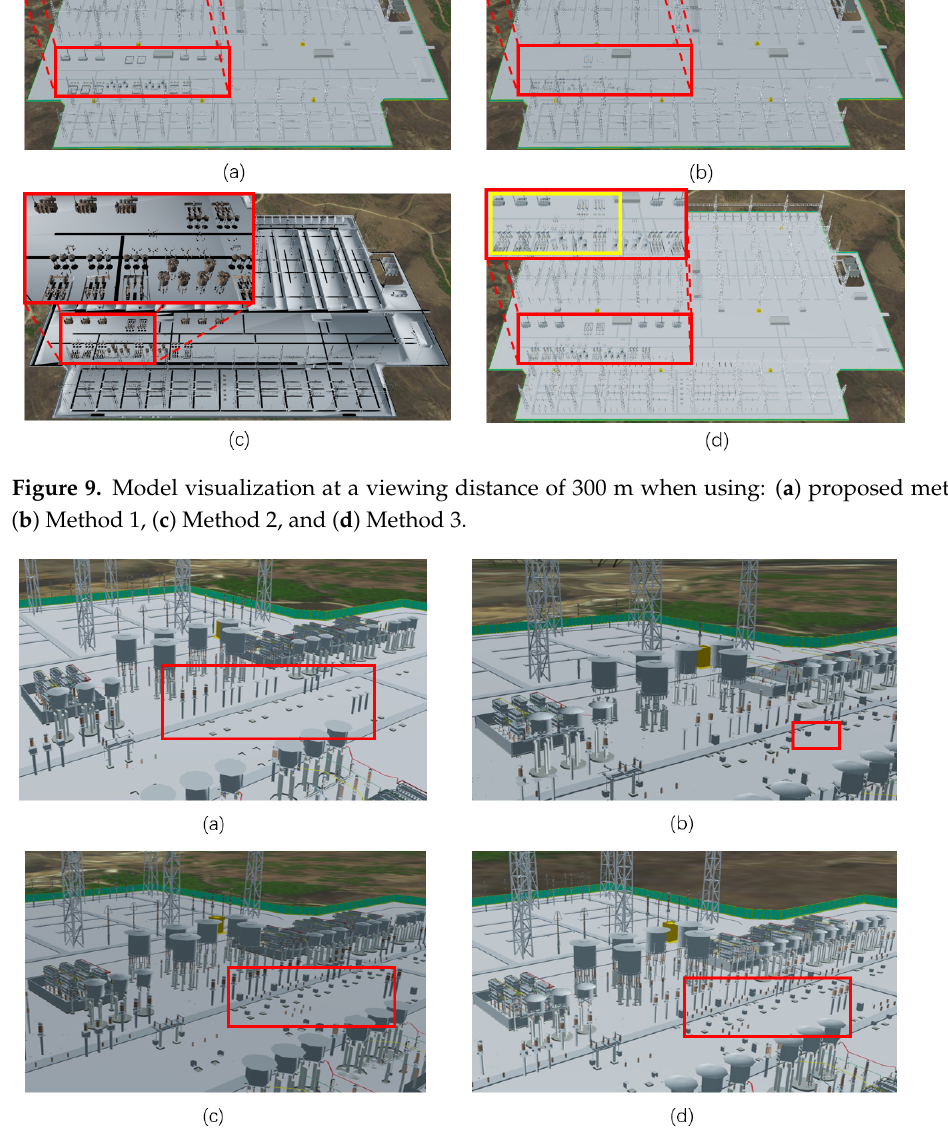
Figure 9. Model visualization at a viewing distance of 300 m when using: ( a ) proposed method, ( b ) Method 1, ( c ) Method 2, and ( d ) Method 3.